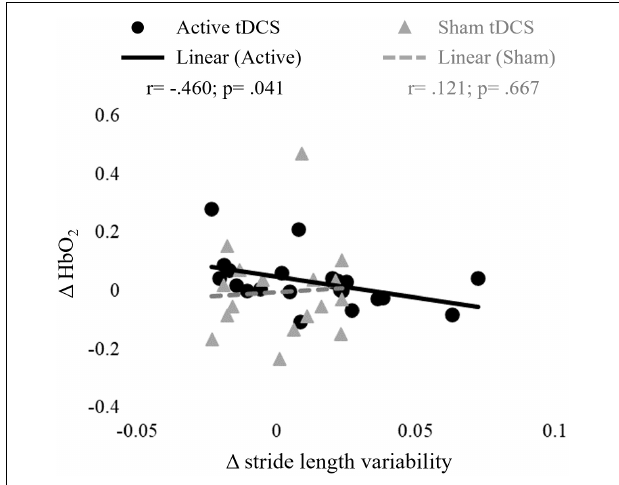
FIGURE 5 | Correlations between changes in oxygenated hemoglobin ( (cid:49) HbO 2 ) in the left prefrontal cortex (PFC) activity and stride length variability in responses to active and sham tDCS stimulation ( (cid:49) POST − PRE